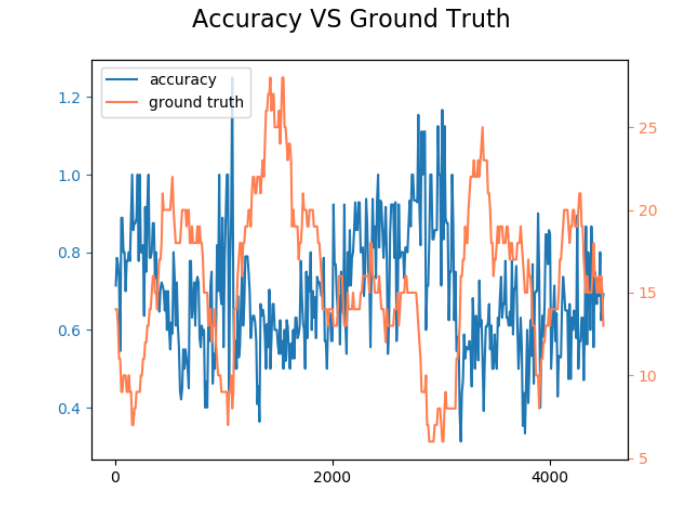
Figure 11. Evolution of the accuracy (blue lines, ideal is 1.0) in accordance with the ground truth (orange lines) over time. Accuracy is better with small groups and decreases with large